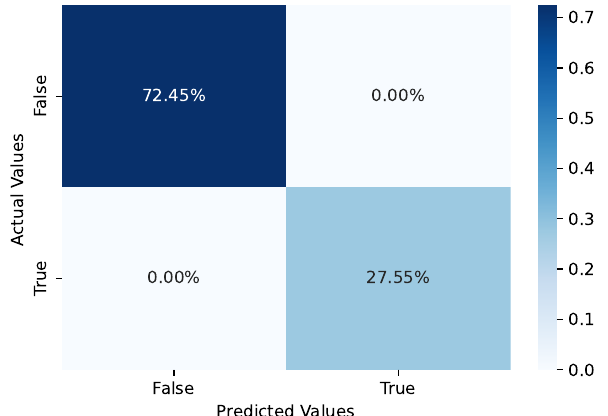
Figure 12. Confusion matrix.